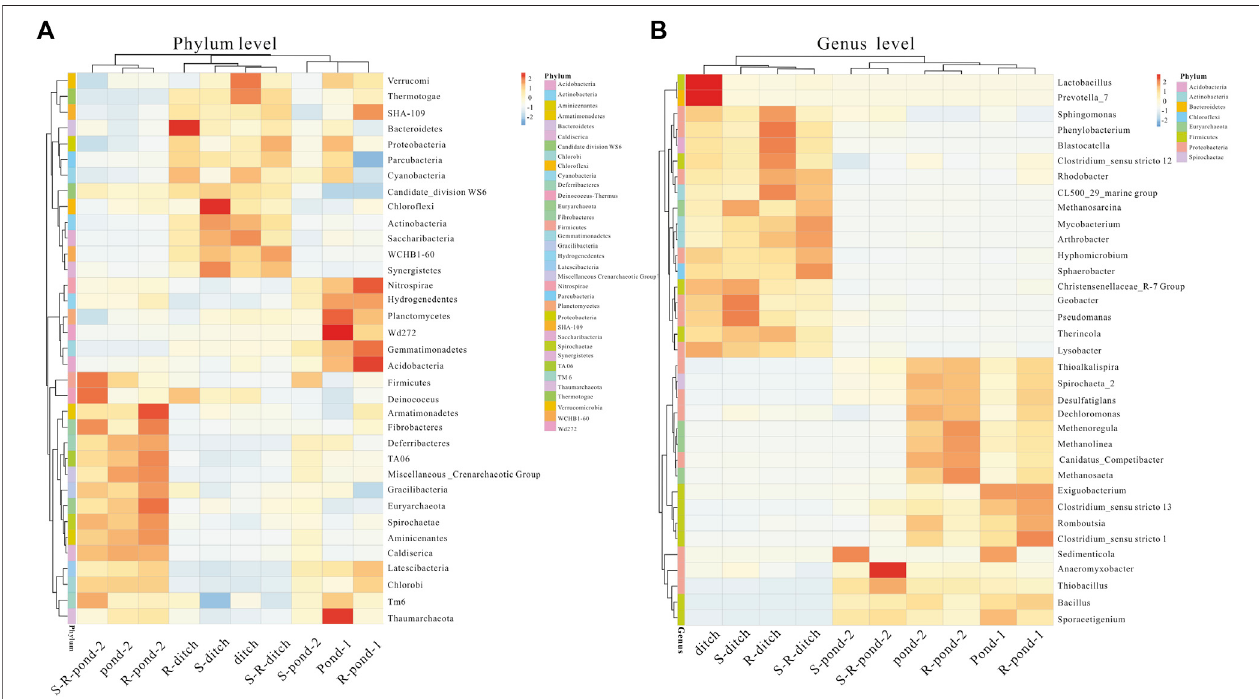
FIGURE4 | Relative abundance heatmap oftop 35 bacteria inrhizosphere and non-rhizosphere sediments in two systems at the phylum (A) and genus (B) levels.